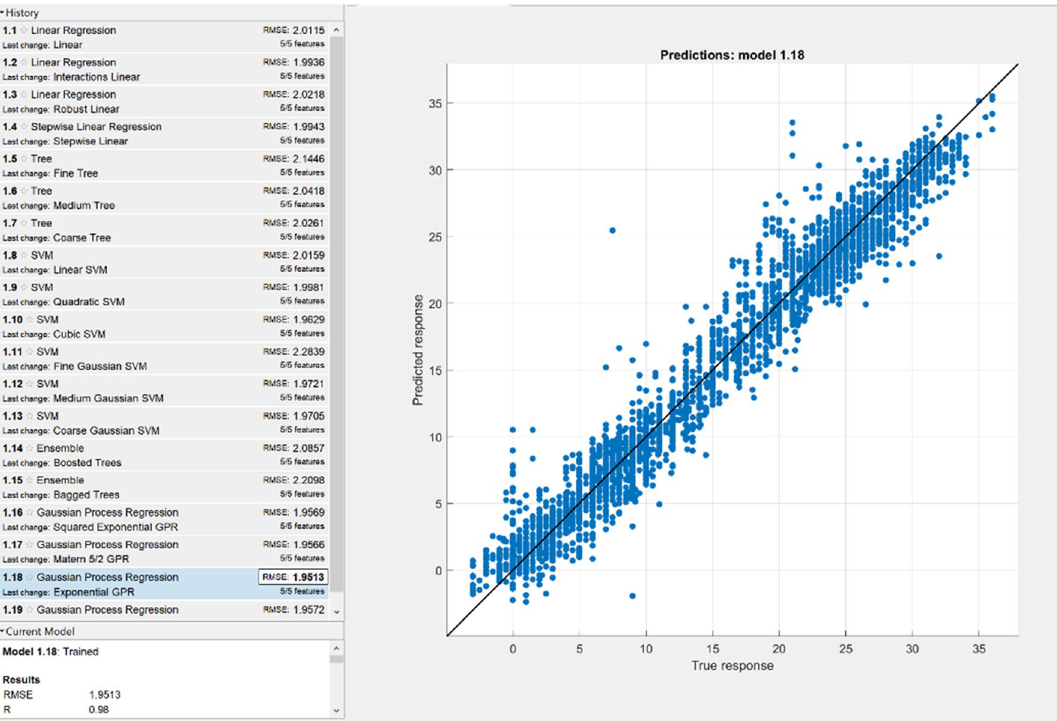
Figure 6. Correlation diagram of selected ML models (RMSE and Pearsons correlation coefficient R) for hourly temperature